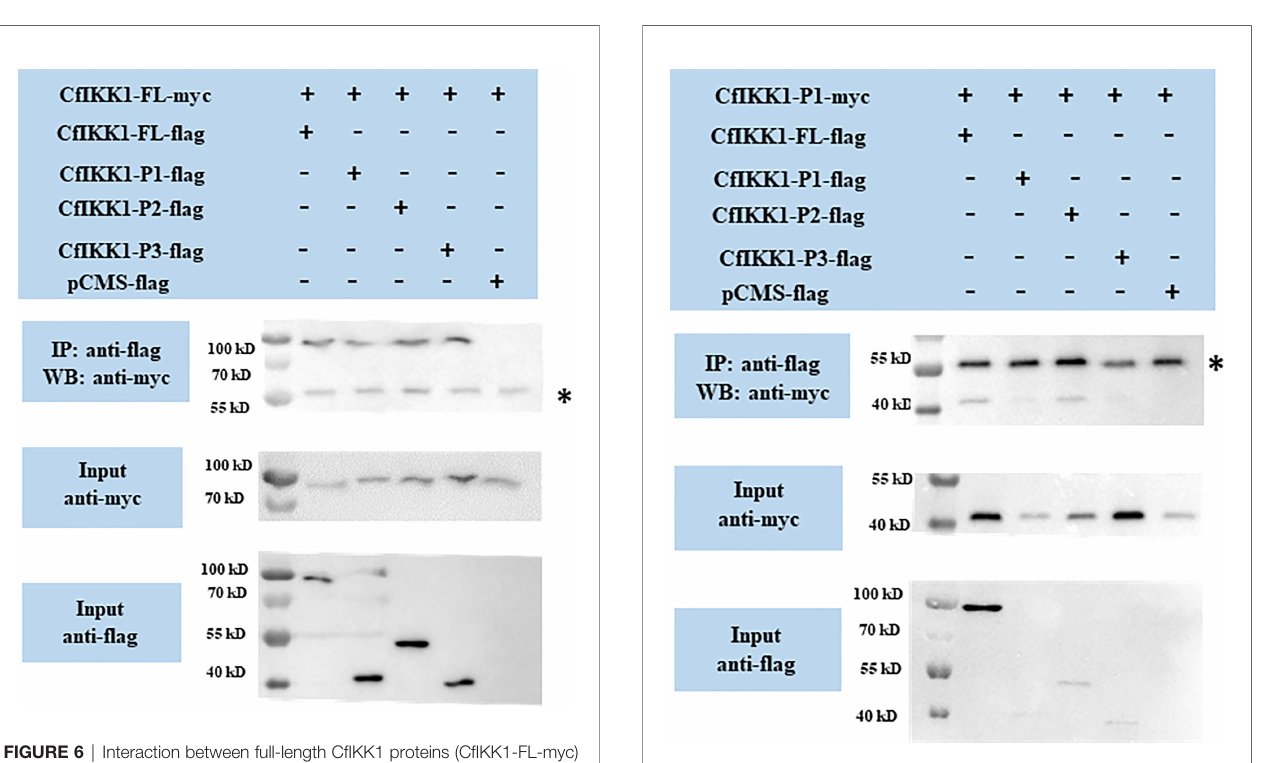
FIGURE 7 | Interaction between the CfIKK1 kinase domain (CfIKK1-P1-myc) and various CfIKK1- fl ag proteins (CfIKK1-FL, CfIKK1-P1, CfIKK1-P2, and CfIKK1-P3), as veri fi ed using co-immunoprecipitation assays. CfIKK1-P1-myc was detected in the anti- fl ag immunoprecipitates of co-transfected (CfIKK1- FL, CfIKK1-P1, and CfIKK1-P2) cell extracts, indicating the interaction of CfIKK1-P1-myc with CfIKK1-FL- fl ag, CfIKK1-P1- fl ag, and CfIKK1-P2- fl ag. Asterisk represents the heavy chain of mouse IgG. IP, co-immunoprecipitation assay; WB, western blot